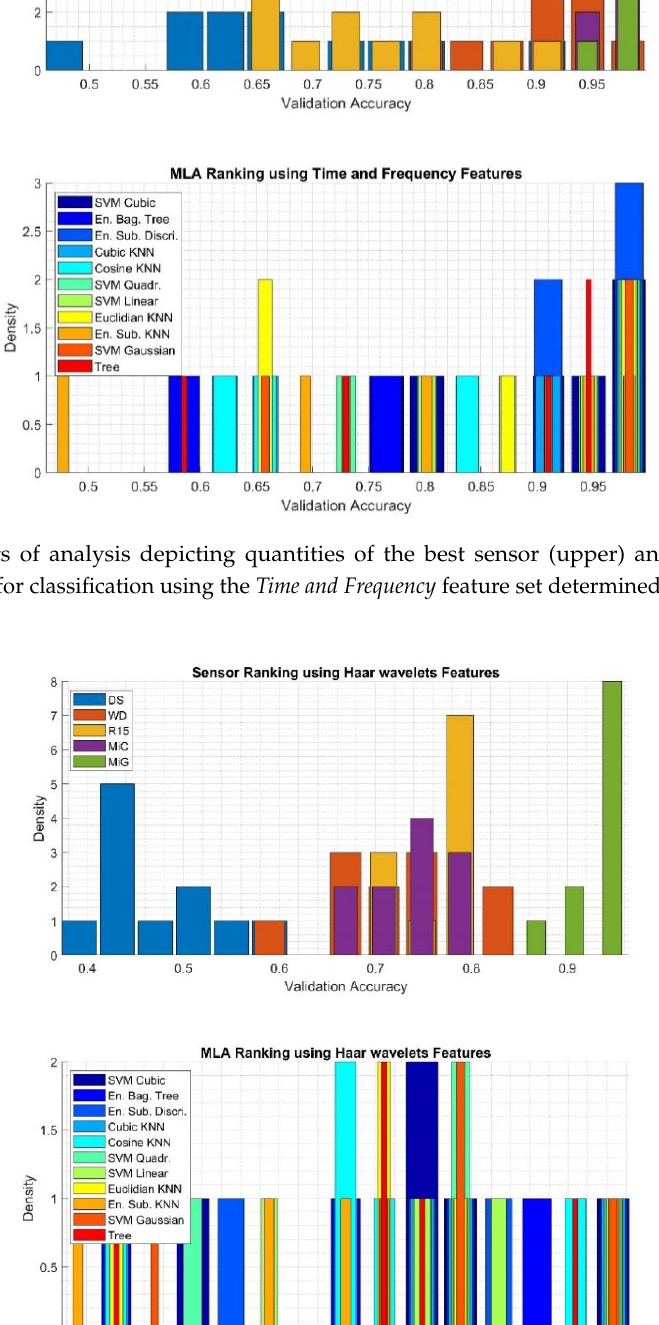
Figure 11. Results of analysis depicting quantities of the best sensor (upper) and the best MLA (bottom) applied for classification using the Welch PSD features determined using validation accuracy value.